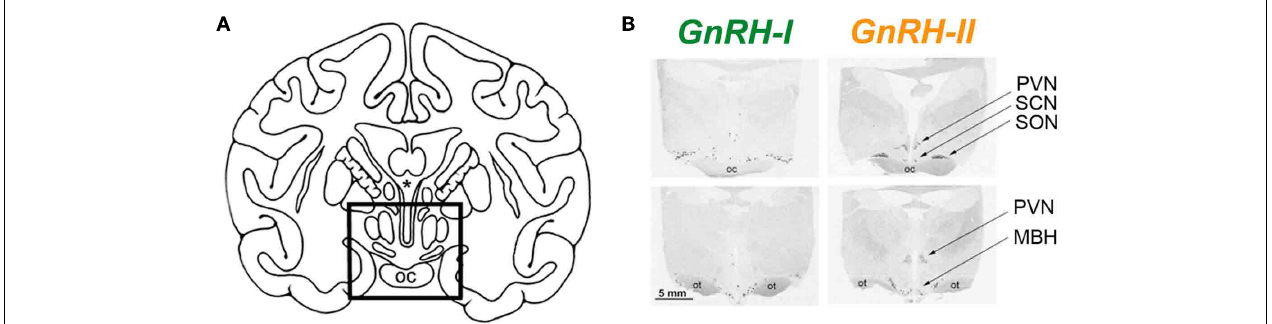
caudal (lower panels) hypothalamic sections. SON, supraoptic nucleus; PVN, paraventricular nucleus; SCN, suprachiasmatic nucleus; MBH, medial basal hypothalamus; oc, optic chiasm; ot, optic tract. (Adapted from Urbanski et al., 1999, with permission from the Endocrine Society).